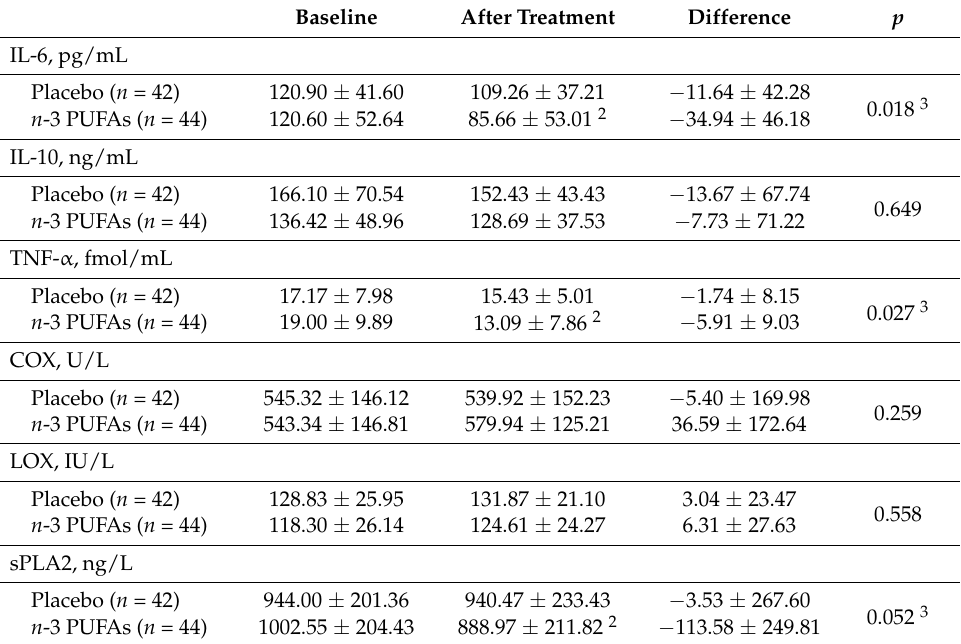
Table 4. The effect of n ‐ 3 PUFAs on the plasma indicators levels of MCI patients 1 . Baseline After Treatment